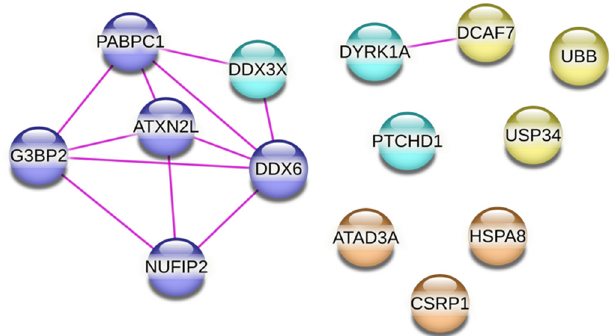
Figure 8. STRING analysis of PTCHD1 -specific interactors. Pink lines show experimentally determined physical interactions between PTCHD1 interactors identified through STRING analysis. DDX3X, PABPC1, ATXN2L, DDX6, G3BP2, and NUFIP2 form a cluster of physical interactions. Pro- teins in cyan are associated with autism. Others are coloured by function: purple—RNA metabolism, yellow—ubiquitylation, and